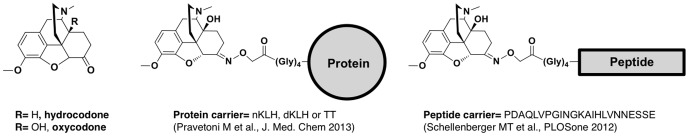
Drug and immunogen structures.Oxycodone and hydrocodone free drugs, and representation of hapten conjugated to carriers. The lead 6OXY hapten was conjugated to native KLH decamer (nKLH), GMP grade KLH dimer (dKLH), tetanus toxoid (TT) and a TT-derived peptide.